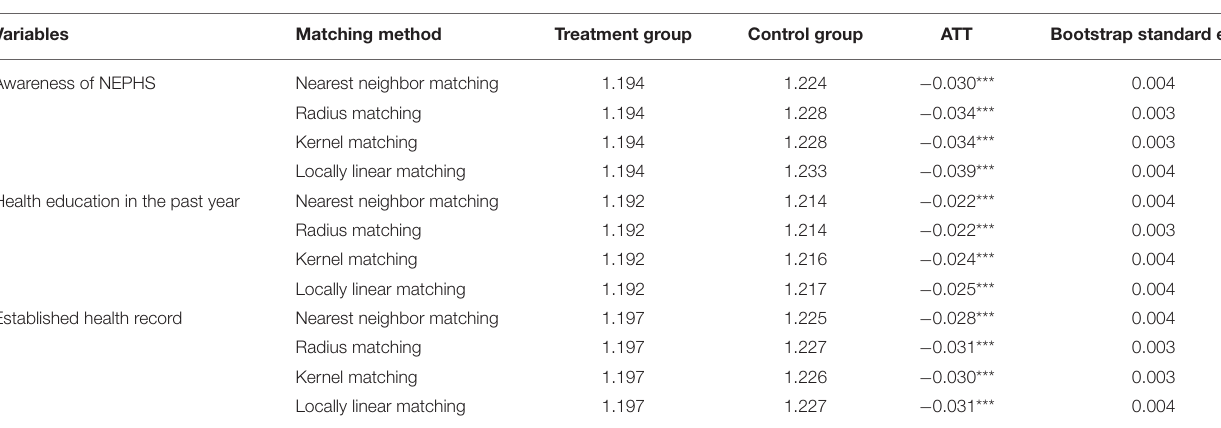
TABLE 4 | PSM estimation